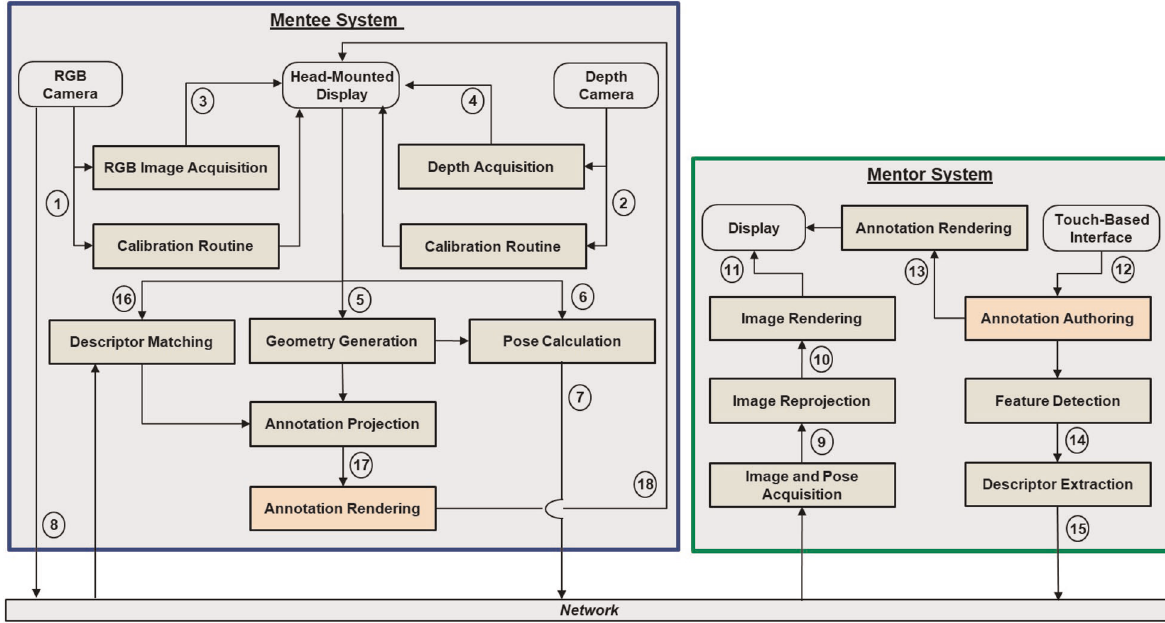
Fig. 2 Architecture of the STAR platform. The view of the local mentee ’ s operating fi eld is transferred over a network connection. After applying image stabilization routines, a remote mentor creates surgical instructions over this view, which are transferred to the mentee. The mentor-authored annotations can be projected onto the patient ’ s body at the correct position and depth thanks to the geometric reconstruction of the operating fi eld created by the ARHMD.